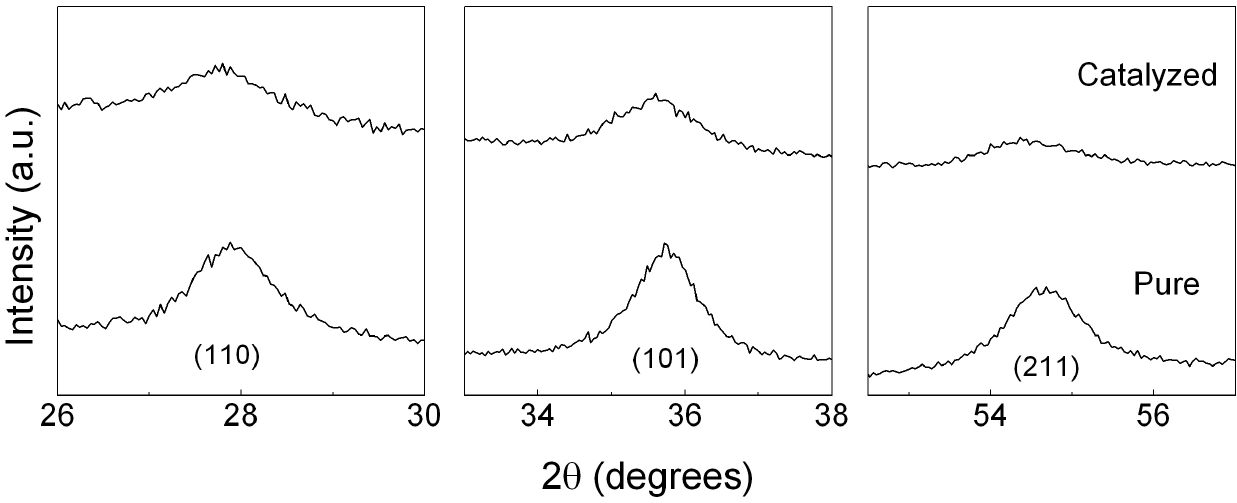
Figure 3. Three strongest peaks of XRD pattern for the catalyzed and pure MgH 120